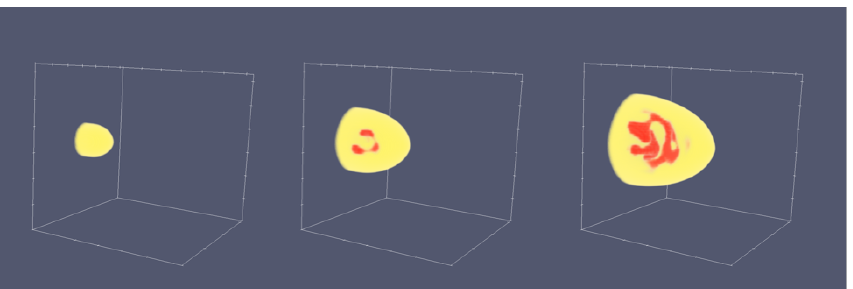
Figure 14. Three-dimensional simulation of the austenite-to-bainite transformation on the subunit level using the phase field model. The surrounding austenite is not shown, the bainitic ferrite is in yellow and the carbides in red, demonstrating their complex microstructure, which results from a chemo-mechanical coupling during the carbide formation via spinodal decomposition.